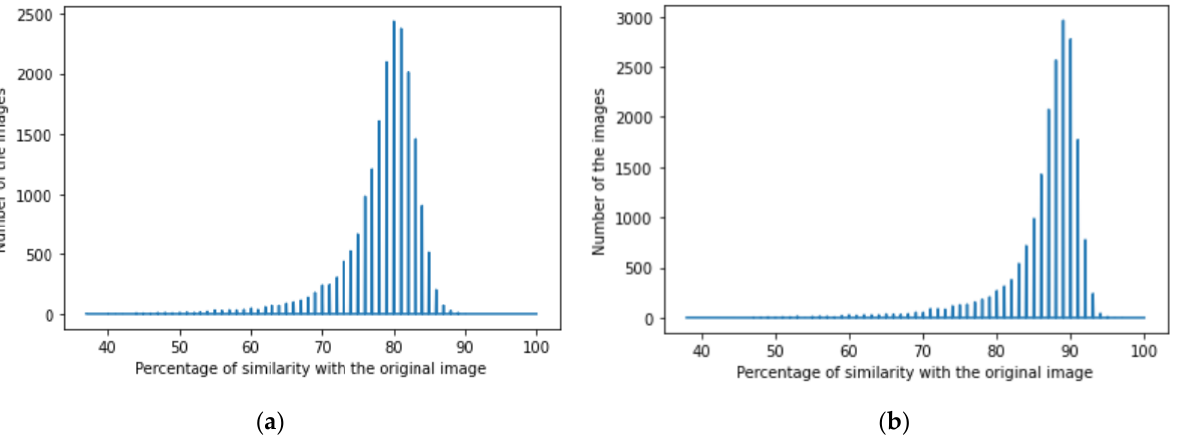
Figure 6. The histogram of similarity between the predicted denoised image and the original image in the case of Gaussian noise: ( a ) one autoencoder with separable convolutional neural networks; ( b ) dual autoencoder with separable convolutional neural networks.